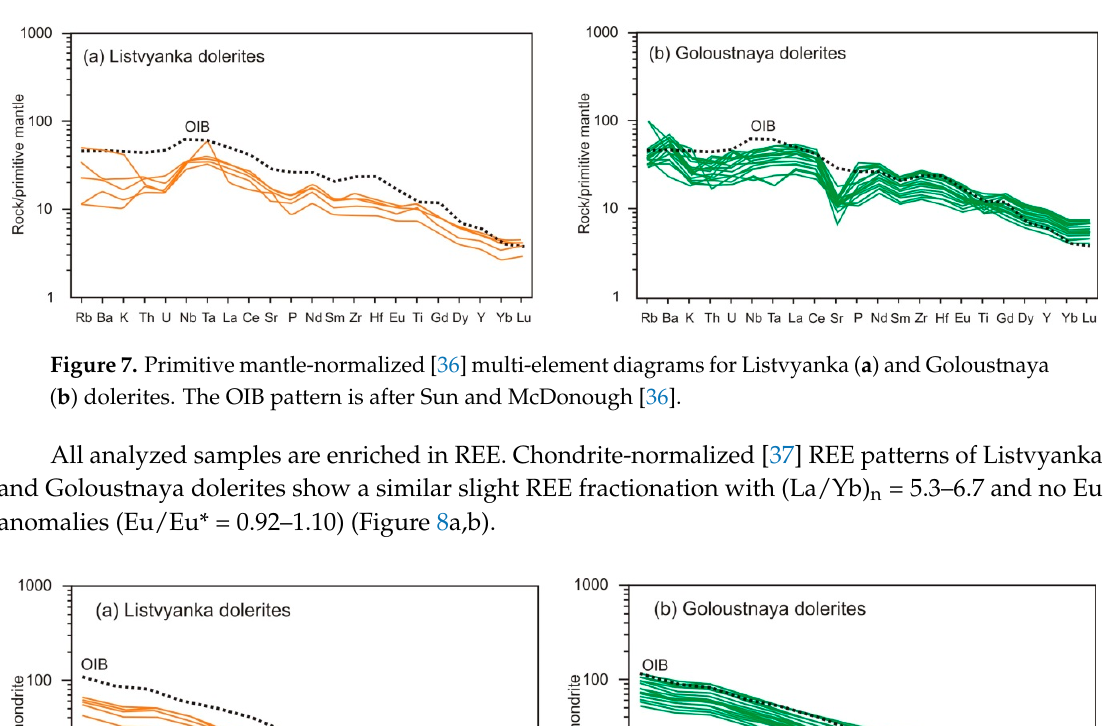
Figure 8. Chondrite ‐ normalized [37] REE patterns for Listvyanka ( a ) and Goloustnaya ( b ) dolerites. The oceanic island basalts (OIB) pattern is after Sun and McDonough [36].